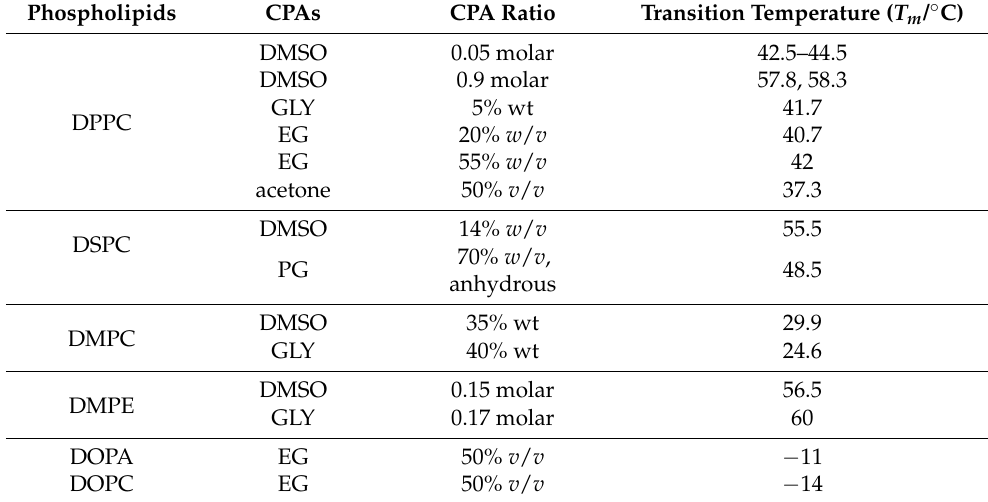
Table 3. Effects of CPA concentrations on membrane phase transition temperatures of lipids